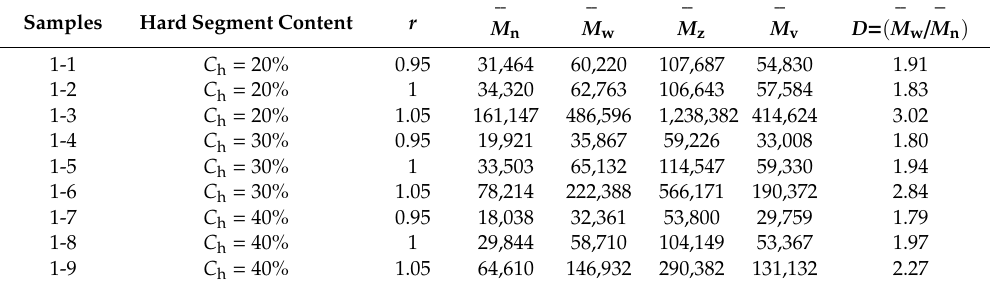
Table 5. Influence of di ff erent hard segment content and r on molecular weight of polyester-based